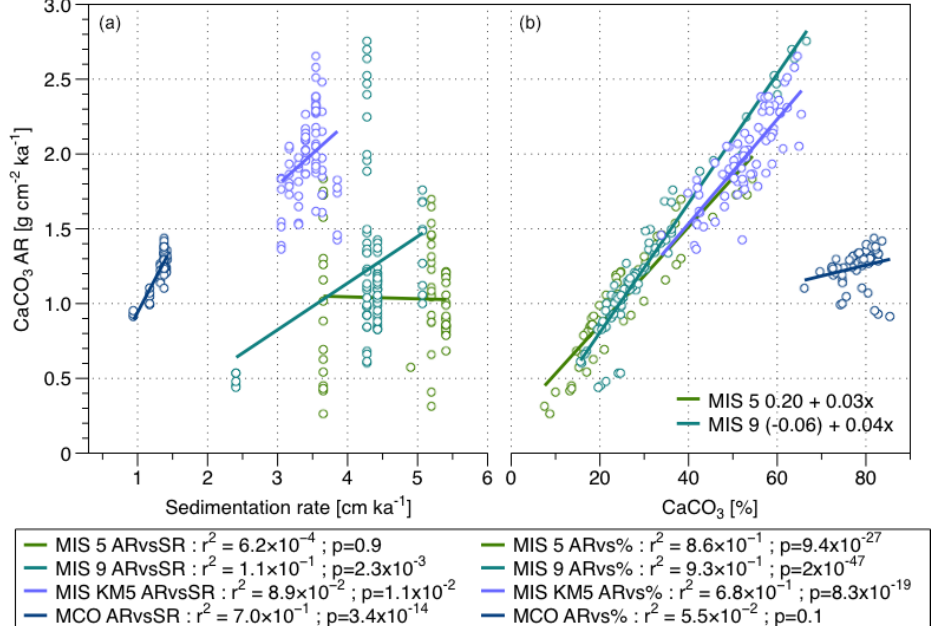
Figure 9. (a) Relationship between the CaCO 3 AR and the SR and (b) relationship between the CaCO 3 AR and the CaCO 3 % for the four periods of